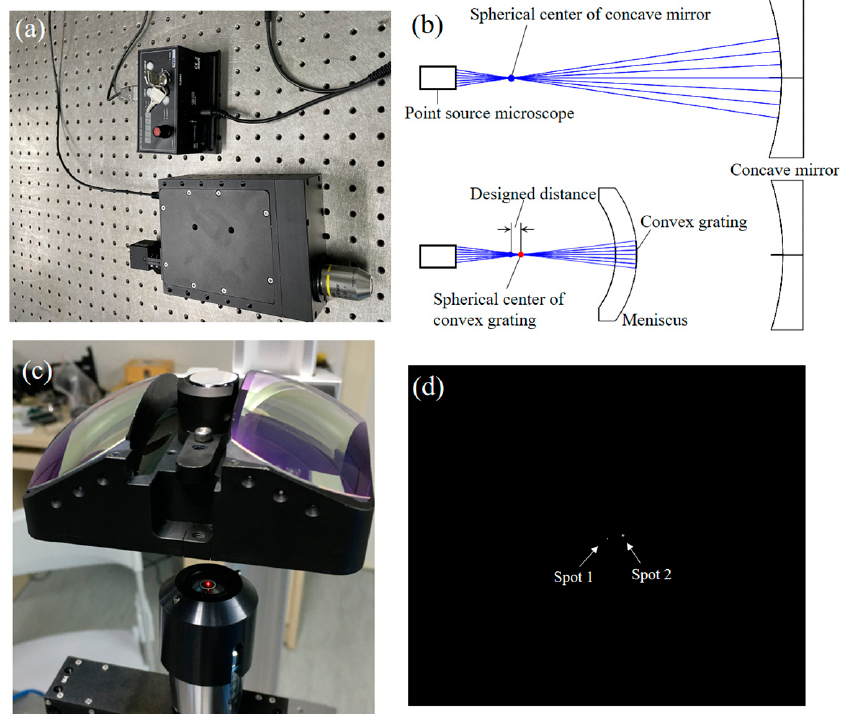
Figure 14. Alignment of spectrometers by utilizing a point source microscope. ( a ) Self-developed point-source microscope, ( b ) alignment of meniscus-grating and concave mirror in B1 and B2 spec- trometers, ( c ) alignment of two separated menisci in B3 spectrometer with point-source microscope, ( d ) star images of two spherical surfaces in the field of the point source microscope.